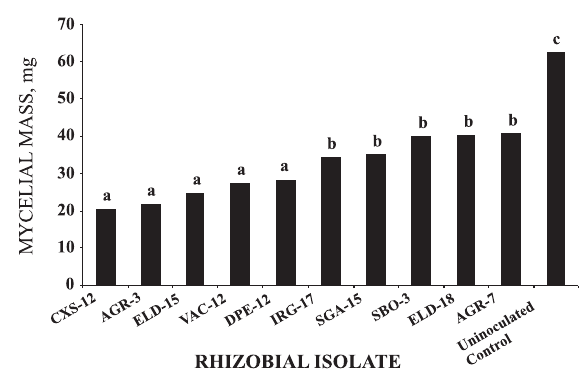
Figure 2. Inhibition of Verticillium sp. mycelial mass production by rhizobial isolates. Means followed by the same letter did not differ significantly at p = 0.05 (Scott-Knott